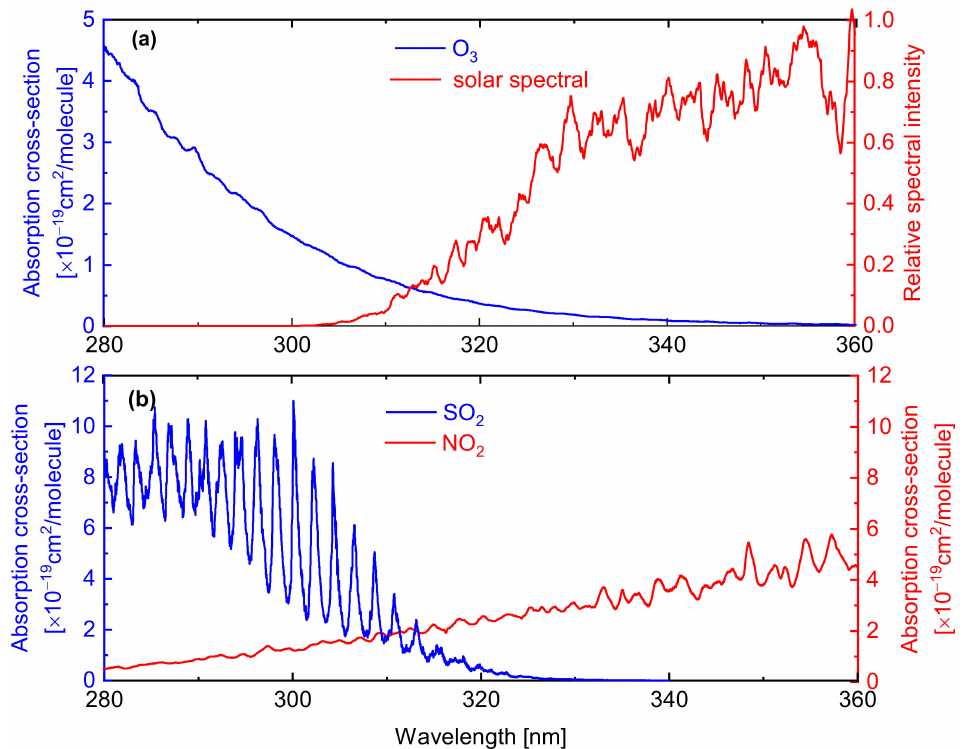
Figure 1. ( a ) Scattered solar relative spectral intensity varying with wavelength (red line) and absorption cross-section of O 3 varying with wavelength (blue line); ( b ) Absorption cross-section of SO 2 (blue line) and absorption cross-section of NO 2 (red line), which are calculated on